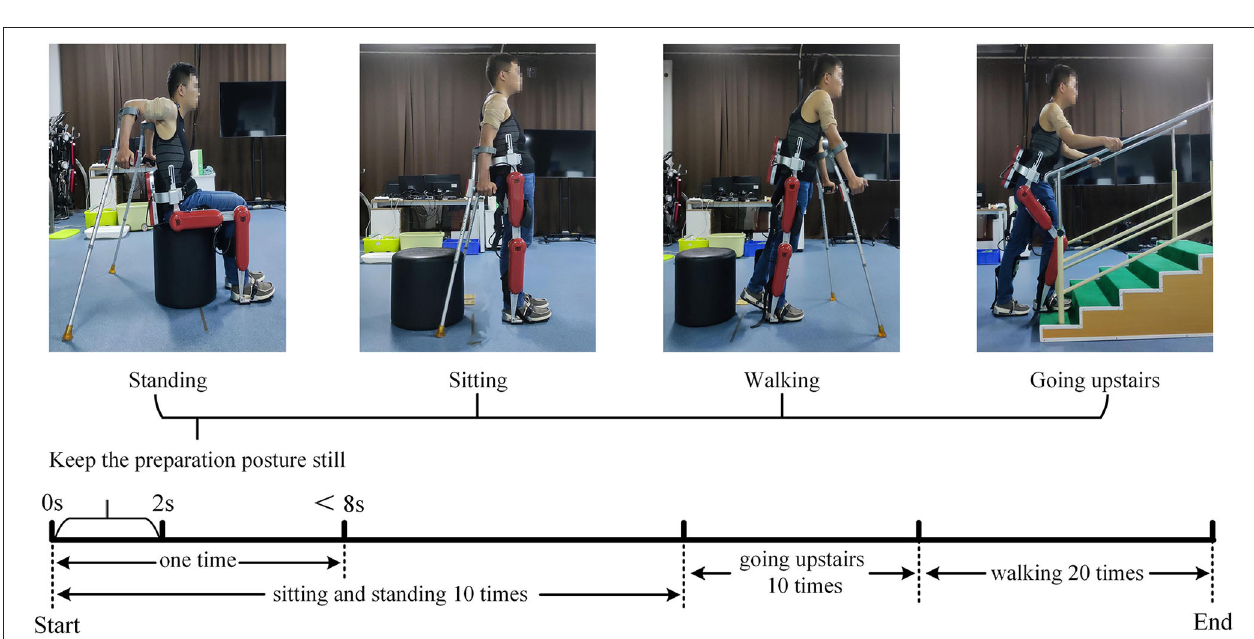
FIGURE 2 | Introduction of the muscle used in the surface electromyography (sEMG) data acquisition experiment and the AssisIve DEvice for paRaplegic patient (AIDER) exoskeleton. (A) The upper limb muscle used in sEMG data acquisition experiment. (B) The AIDER exoskeleton is designed for walking assistance of paraplegic patients, and it can help the paraplegic patient complete some ADL movements such as sitting, standing, walking, and going upstairs movement. 1: The subject; 2: the embedded computer and IMU; 3: the crutches; 4: DC servo motors; 5: intelligent shoes with plantar pressure sensors inside.